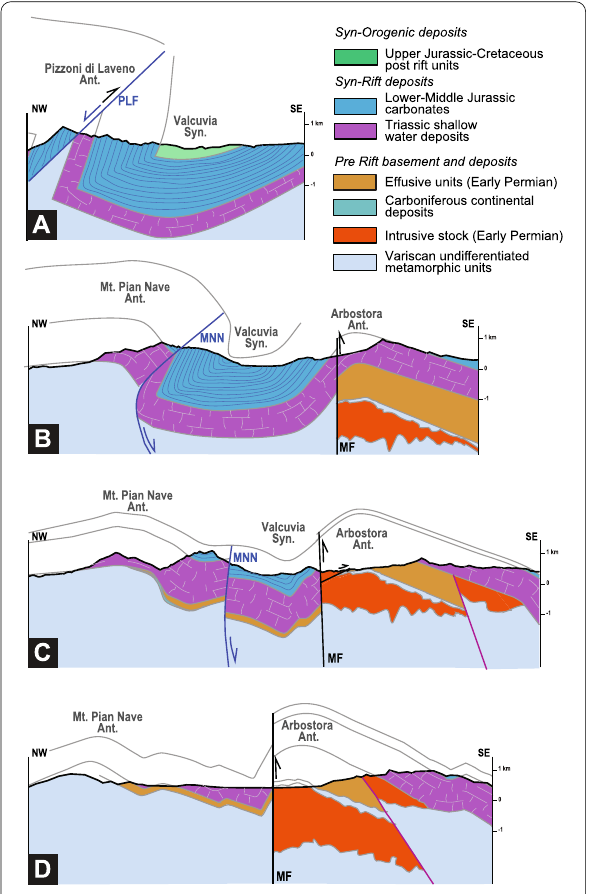
Fig. 5 Geological cross-sections across the Varese Area (see Fig. 2 for section trace); same codes as Fig. 2